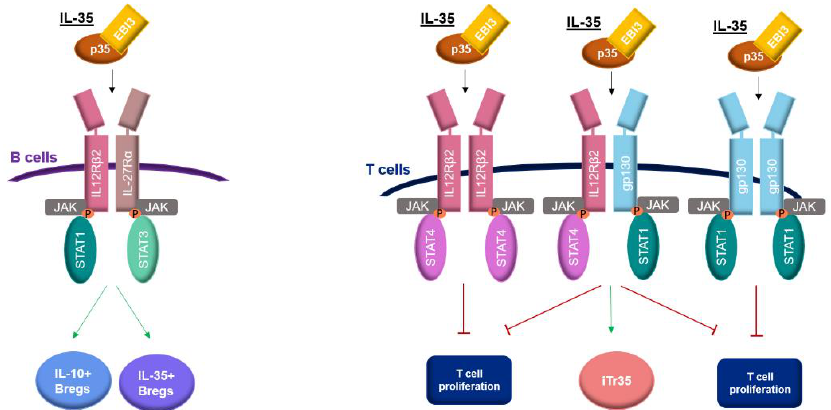
Figure 1. Receptor and signaling pathway of IL-35. IL-35 (Interleukin 35), IL-12R β 2 (Interleukin 12 receptor subunit beta 2), IL-27R α (Interleukin 27 receptor subunit alpha), JAK (Janus kinase), P (Phosphorus), STAT1 (Signal transducer and activator of transcription 1), STAT3 (Signal transducer and activator of transcription 3), IL-10+Bregs (IL-10-producing regulatory B cells), IL-35+Bregs (IL- 35-producing regulatory B cells, STAT4 (Signal transducer and activator of transcription 4), gp130 (Glycoprotein 130), iTr35 (IL-35-producing T cells). In B cells, IL-35 signals through IL-12R β 2-IL- 27R α and promotes the phosphorylation of STAT1 and STAT3, thereby inducing the generation of IL-35+Bregs and IL-10+Bregs. In T cells, IL-35 signaling through IL-12R β 2-IL-12R β 2 and gp130-gp130 leads to the phosphorylation of STAT4 and STAT1, respectively, resulting only in T cell suppression. IL-35 signal transduction via IL-12R β 2-gp130, which activates STAT 4 and STAT1, can mediate the T cell suppression and induction of iTr35. The complete receptor of IL-12R β 2-gp130 is required for the generation of iTr35. The green arrows indicate induction effects, and the red T-shaped ends indicate suppression effects.